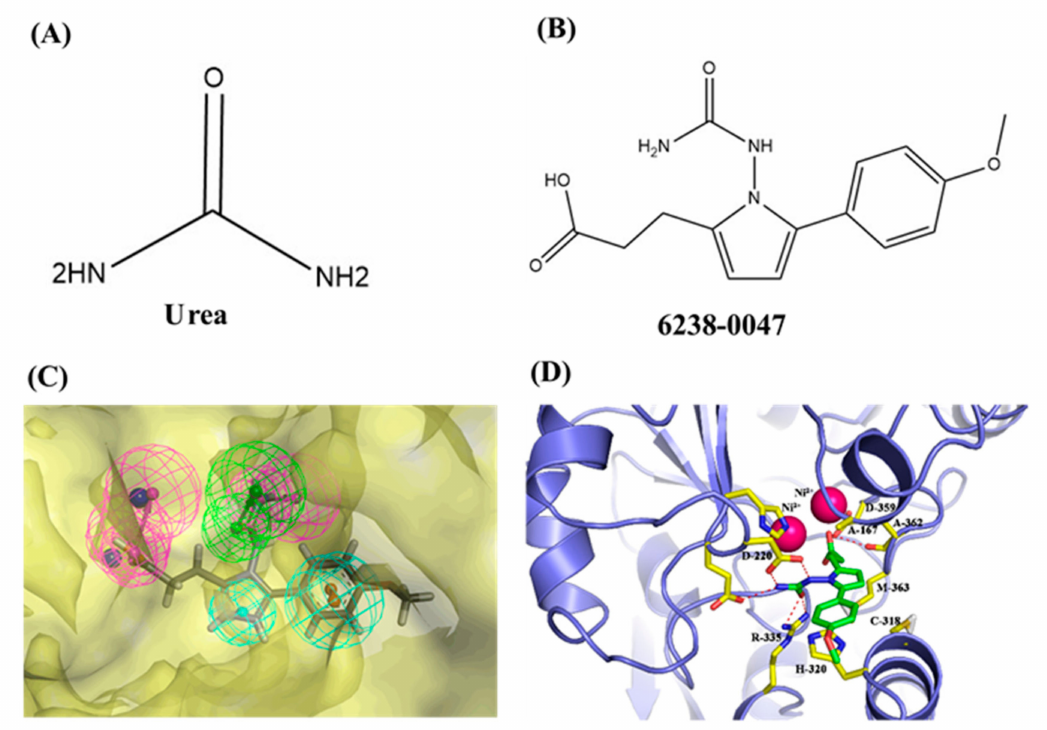
Figure 8. Chemical information and binding mode of compound 6238-0047. The structural formula and the chemical name of urea ( A )and compound 6238-0047 ( B ). The structure properties of compound 6238-0047 were verified by the receptor-ligand pharmacophore between compound 6238-0047 and the ruminal metagenomic urease active site ( C ). Binding mode of compound 6238-0047 with the active site of the ruminal metagenomic urease homology model was revealed by molecular docking ( D ). The surface of the active site pocket and the nickel ions are shown in transparent yellow color and blue color, respectively. The web spheres in green, light blue, and rose red indicate the hydrogen bond acceptor, hydrophobic fragments, and hydrogen bond donor, respectively. The chemical structure of compound 6238-0047 was superimposed to its pharmacophore in grey color. The active site is colored in light purple color while its critical amino acid residues are represented by a yellow stick. Compound 6238-0047 is depicted in green color, while their hydrogen-bond-related functional groups are painted in red and blue, respectively. The red dotted lines indicate where the hydrogen bonds formed. Two nickel atoms are demonstrated in rose